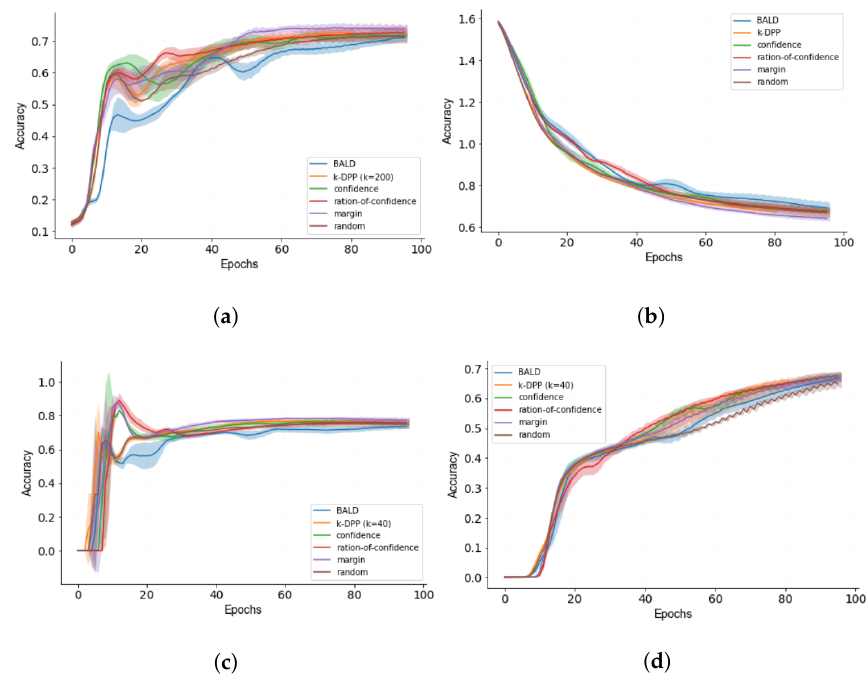
1,40,200,400 . Results are averaged over five ∈ { }